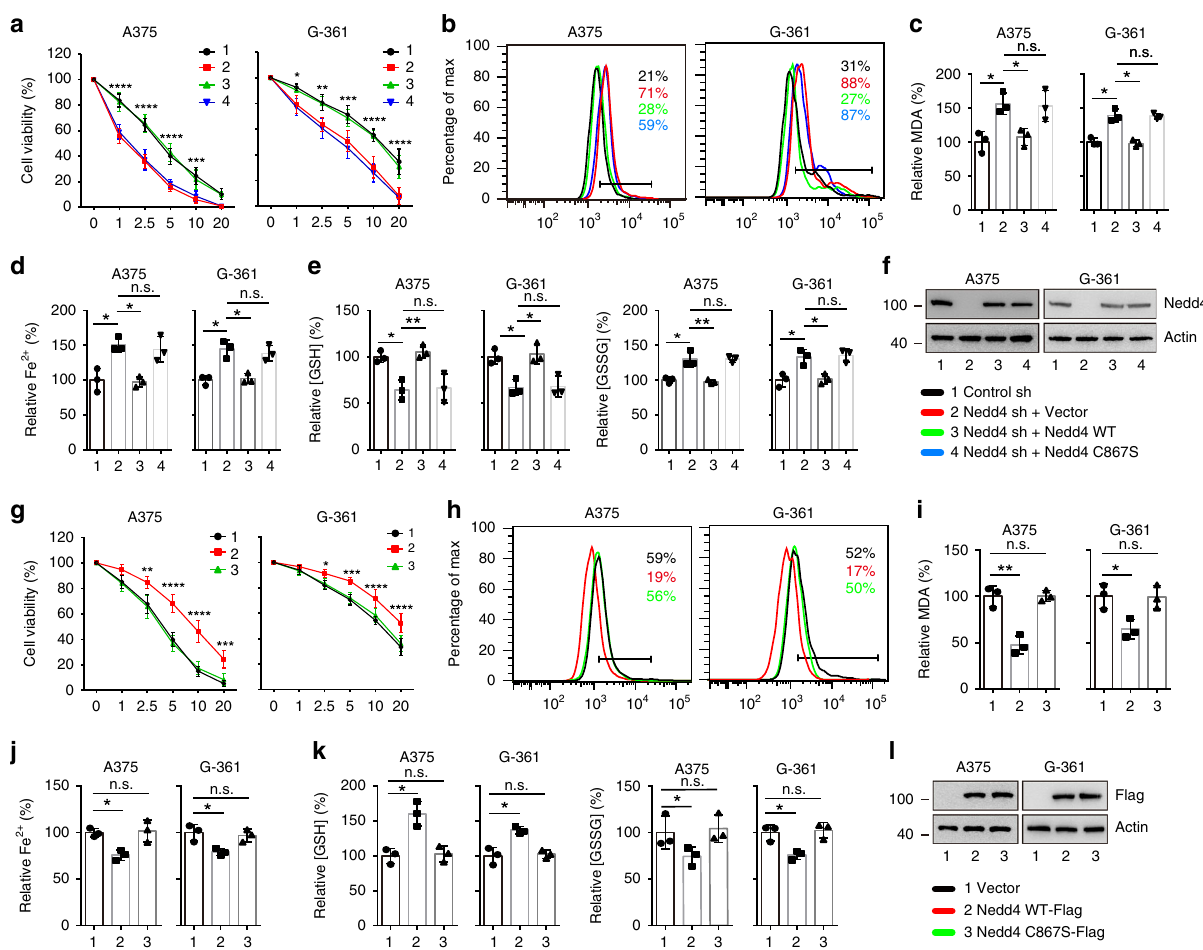
Fig. 4 Nedd4 regulates erastin-induced ferroptosis. a – f Knockdown of Nedd4 enhanced erastin-induced ferroptotic cell death. Indicated cells were treated with erastin (1 – 20 µ M) for 24 h, and cell viability was assayed using a CCK8 kit ( a ). Indicated cells were treated with erastin (5 µ M) for 24 h, the lipid ROS level was assessed by fl ow cytometry using C11-BODIPY ( b ), and the lipid formation was measured by MDA assay ( c ). The accumulation of Fe 2 + was measured by iron detection assay ( d ), concentrations of GSH, and GSSG were detected by relative assay kits ( e ). The expression of Nedd4 was assessed by immunoblotting and compared to actin levels ( f ). Number 1 and black color represent control sh group; number 2 and red color represent Nedd4 sh + Vector group; number 3 and green color represent Nedd4 sh + Nedd4 WT group; number 4 and blue color represent Nedd4 sh + Nedd4 C867S group. g – l Overexpression of Nedd4 suppressed erastin-induced ferroptotic cell death. Indicated cells were treated with erastin (1 – 20 µ M) for 24 h, and cell viability was assayed using a CCK8 kit ( g ). Indicated cells were treated with erastin (5 µ M) for 24 h, the lipid ROS level was assessed by fl ow cytometry using C11-BODIPY ( h ), and the lipid formation was measured by MDA assay ( i ). The accumulation of Fe 2 + was measured by iron detection assay ( j ), concentrations of GSH and GSSG were detected by relative assay kits ( k ). The expression of Nedd4 was assessed by immunoblotting and compared to actin levels ( l ). Number 1 and black color represent vector group; number 2 and red color represent Nedd4 WT-Flag group; number 3 and green color represent Nedd4 C867S-Flag group. Data shown represent mean ± SD from three independent experiments. Comparisons were made using Student ’ s t test and one-way ANOVA. * p < 0.05; ** p < 0.01; *** p < 0.001; **** p < 0.0001; n.s. not signi fi melanoma cells (Supplementary Fig. 5b – g). These results indi- cate that Nedd4 speci fi cally regulates erastin-induced ferroptosis in melanoma cells.